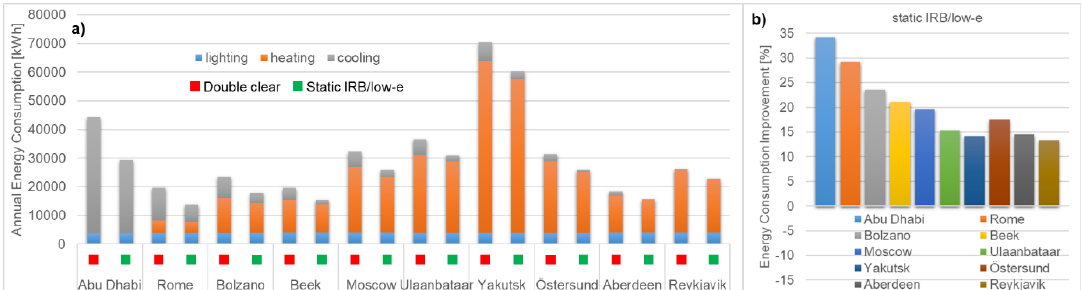
Figure 8. ( a ) Annual energy consumption due to lighting, heating and cooling of a residential building equipped with double clear or static IRB / low-e glazing at various locations; ( b ) annual energy consumption improvement of static IRB / low-e glazing in comparison to clear glass for various locations.